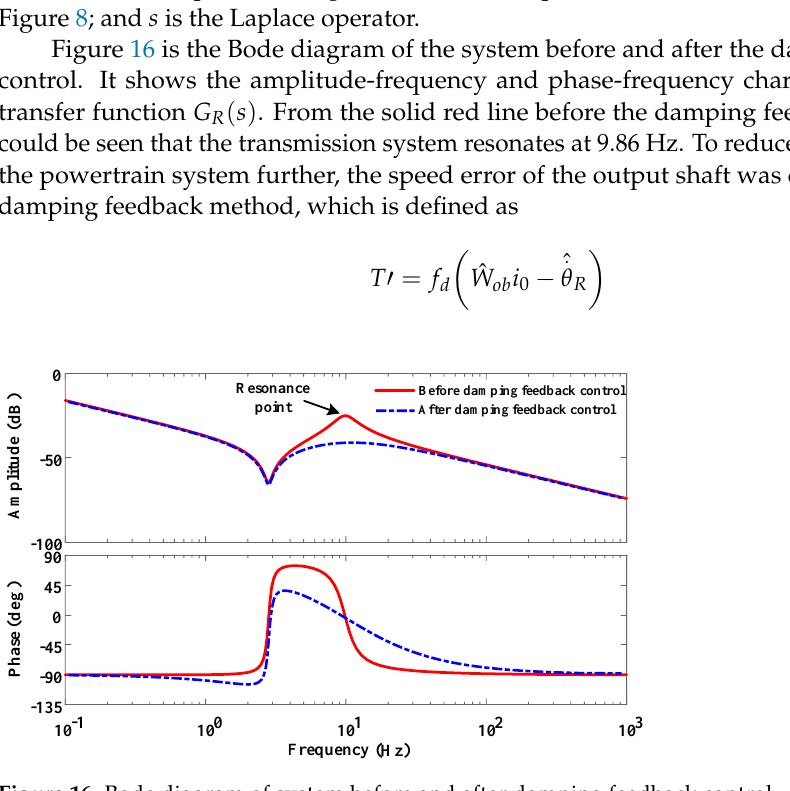
Figure 16. Bode diagram of system before and after damping feedback control.